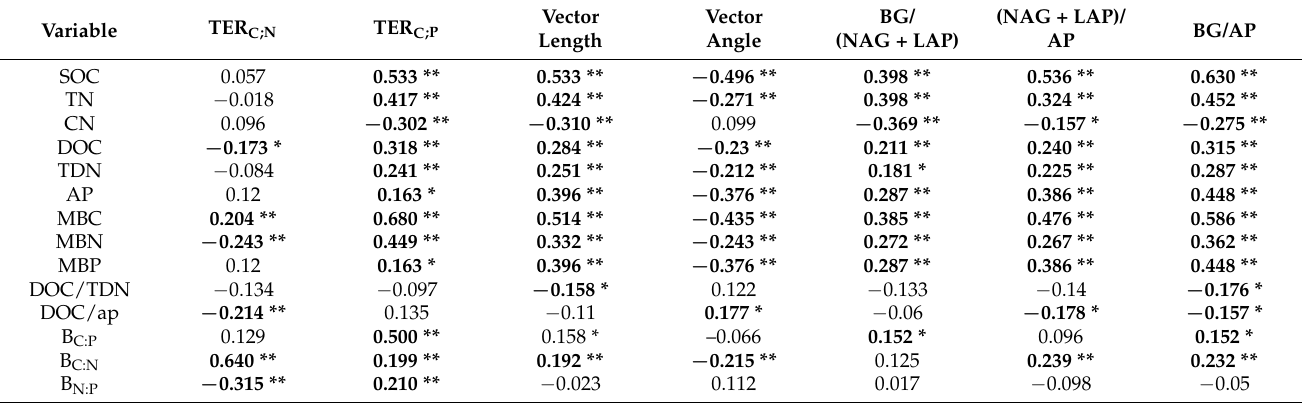
Note: Bold values with one or two asterisks indicate that the relationships are significant or highly significant ( p value < 0.05 or p value < 0.01). Information about the abbreviations can be found